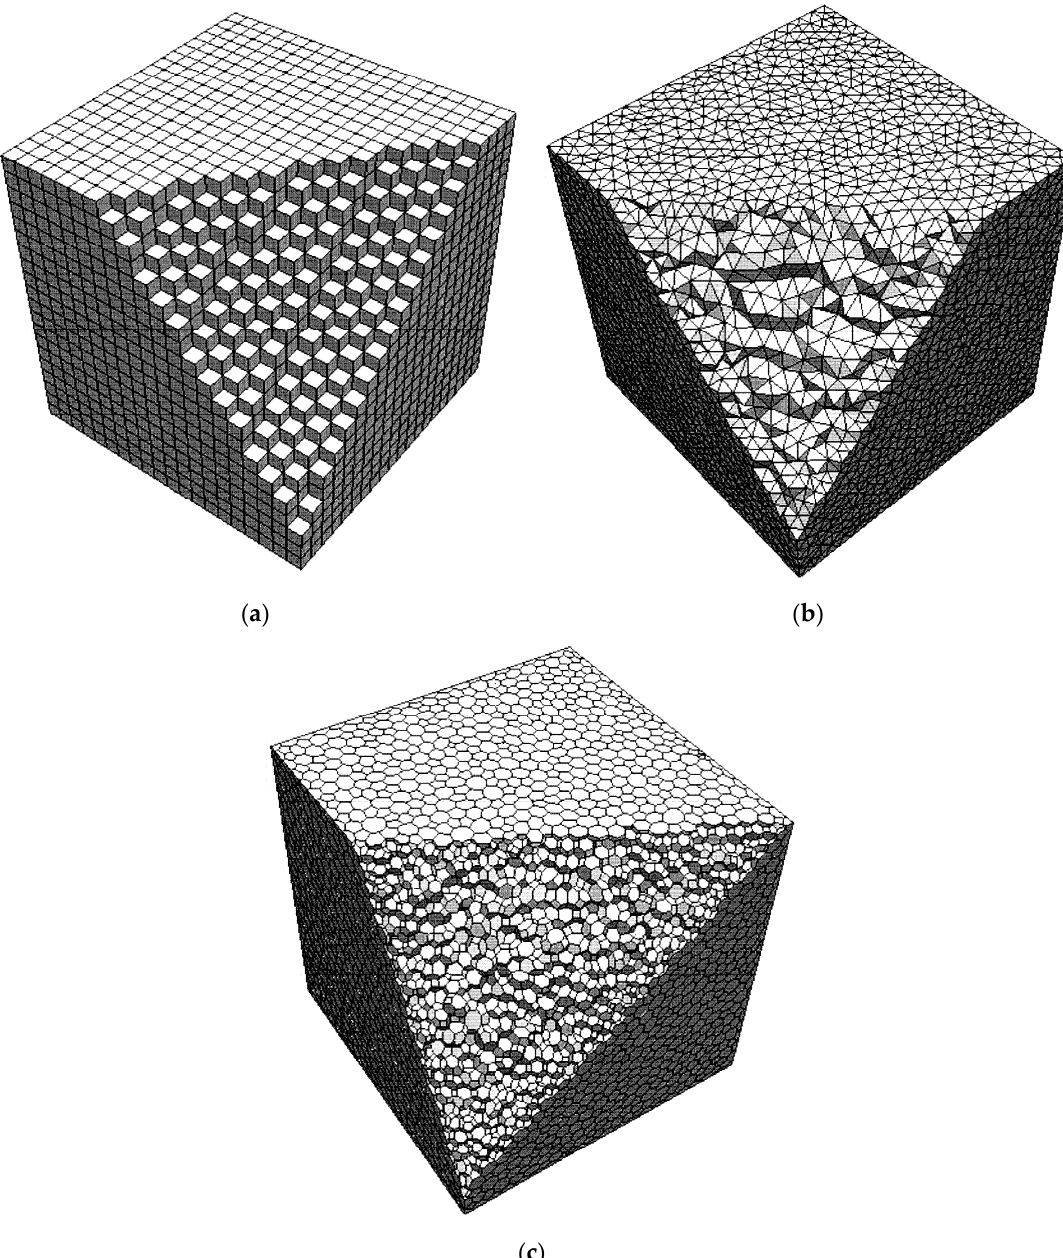
Figure 8. Three different types of meshes used in numerical tests. ( a ) Hexahedral mesh; ( b ) Figure 8. Three di ff erent types of meshes used in numerical tests. ( a ) Hexahedral mesh; ( b ) Tetrahedral Tetrahedral mesh; ( c ) Polyhedral mesh. mesh; ( c ) Polyhedral